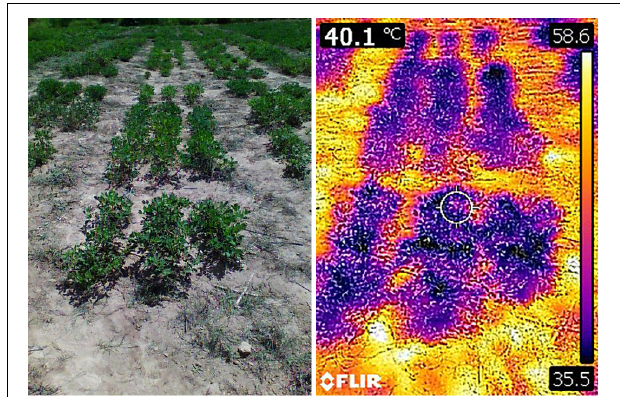
FIGURE 2 | RGB image of selected plot taken using FLIR C2 camera (left side) and corresponding thermal image (right side) as seen in FLIR Tools